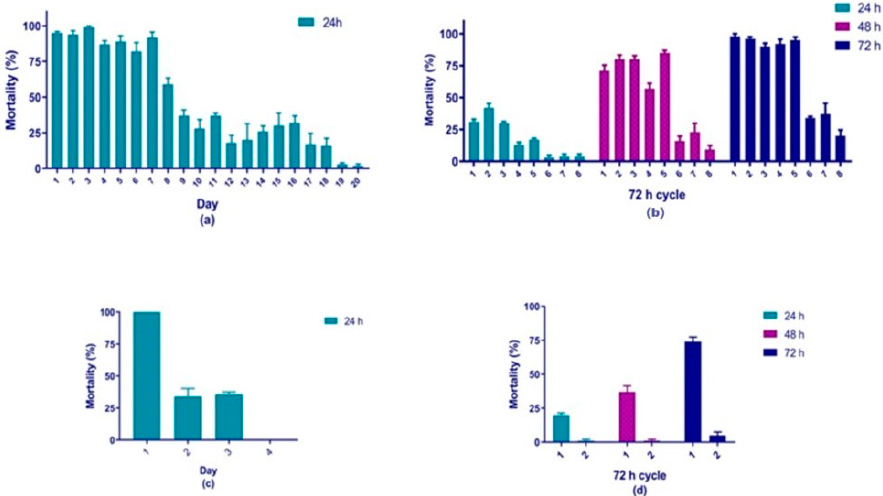
Figure 2. ( a ) Tectoquinone ( 4 ) laboratory residual larvicide effect after 20 days. Larvae mortality was